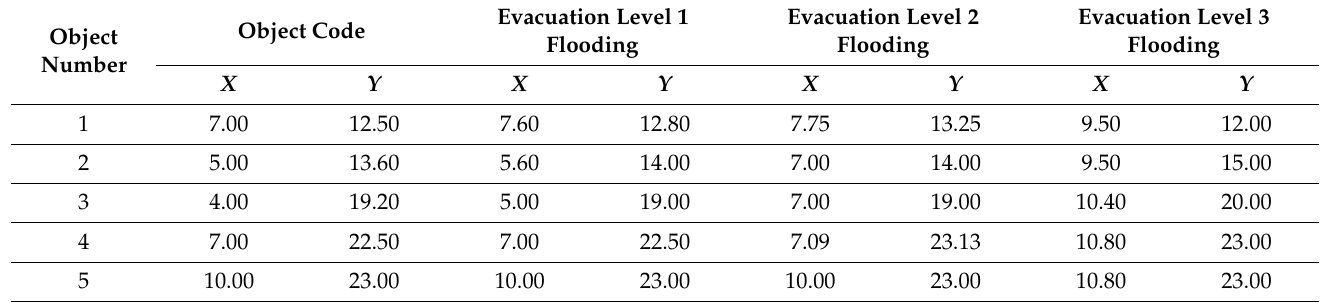
Figure 9. Evacuation points at realized, three levels of flooding. Table 1 lists the initial coordinates of the site and the coordinates of the corresponding evacuation points for the considered flood levels. Table 1. Coordinates of objects and their corresponding evacuation